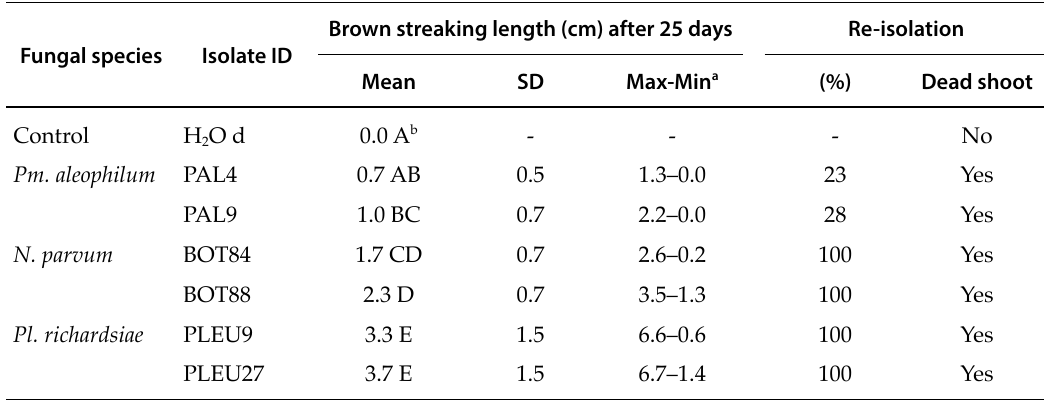
a Maximum and minimum values detected on the basis of 20 observations. b Values followed by a different capital letter in each column are significantly different according to Duncan’s test ( P >0.01